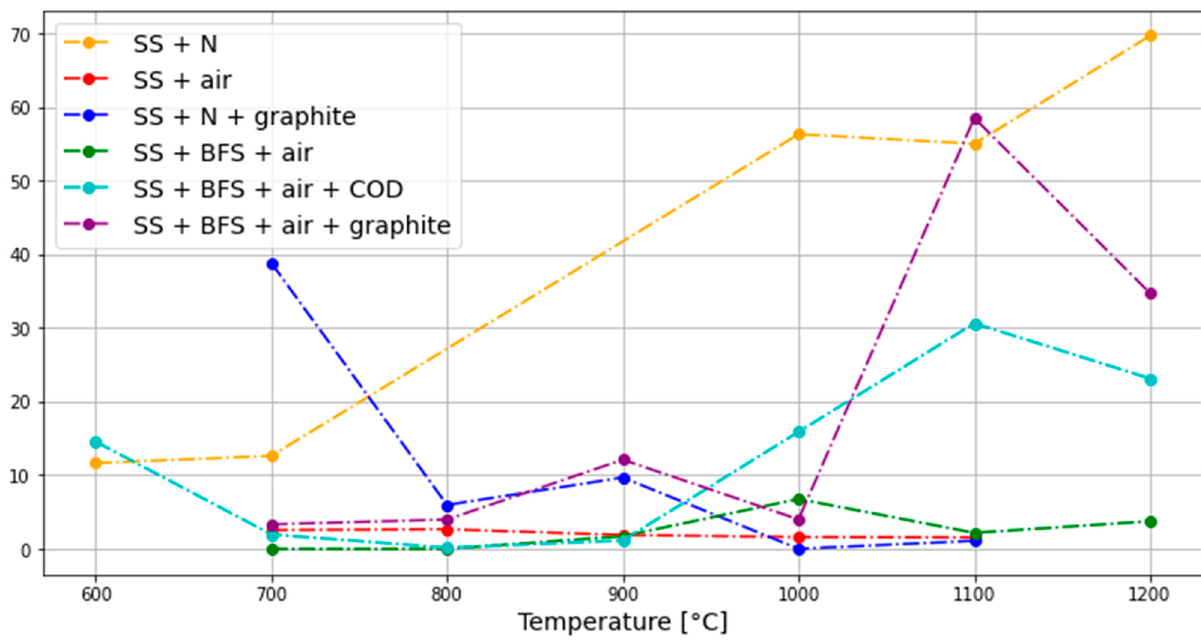
Figure 5. Effect of temperature, atmosphere and reducing element on metallic Fe content in sludge. The thermal treatment of sludge has a secondary effect, i.e., a reduction in iron con- tent. The highest reduction in iron in the SS+BFS+air+graphite charge, at a temperature of 1000 °C was achieved, when the metallic Fe content increased to 65 wt.%. Generally, the content of reduced Fe is increasing for all tested mixtures. The C contained in the sludge was also used to reduce oxygen from the sludge, the content of which decreased after heat treatment (Figure 6). The carbon content of the batch dropped to zero, using the batch without additional reducing agent and under the simul- taneous action of an air atmosphere. On the contrary, in the batch with a graphite reducing agent and under the influence of air, there was 3.6 wt.% C remained in the sludge after